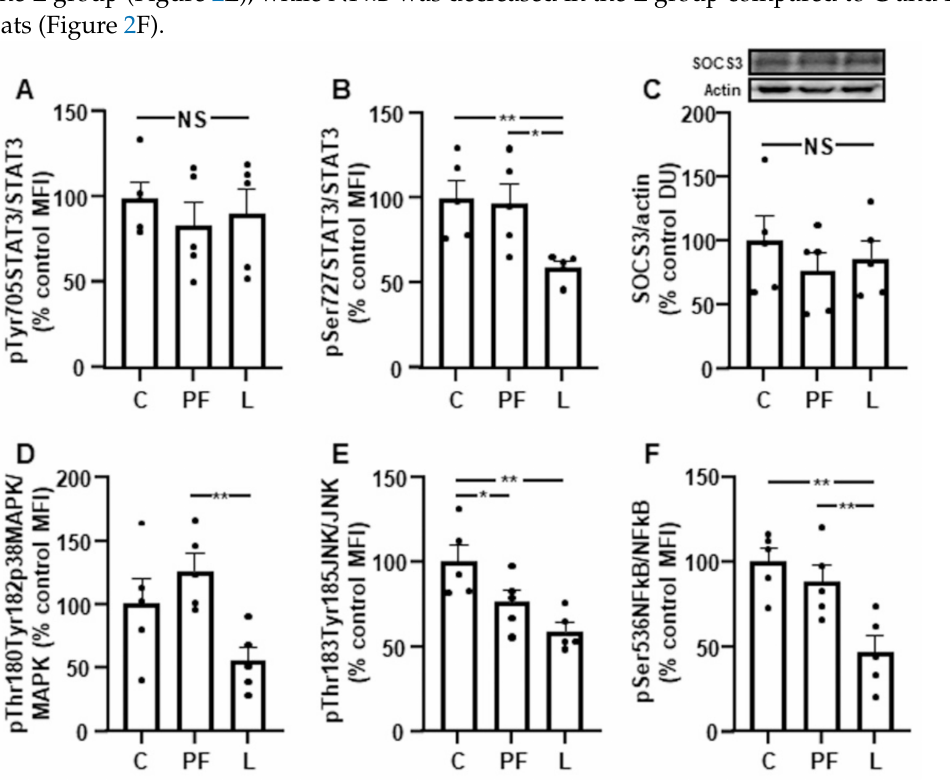
Figure 2. Effect of chronic central leptin infusion on activation of leptin and inflammatory targets. Rel- ative protein levels of ( A ) signal transducer and activator of transcription 3 (STAT3) phosphorylated (p) on Tyr705 (pTyr705STAT3), ( B ) phosphorylated STAT3 on Ser727 (pSer727STAT3), ( C ) suppressor of cytokine signaling (SOCS)3, ( D ) phosphorylated p38 mitogen-activated protein kinase (p38MAPK) on Thr180 and Tyr182 (pThr180Tyr182p38MAPK), ( E ) c-Jun N-terminal kinase (JNK) phosphorylated on Thr183 and Tyr185 (pThr183Tyr185JNK) and ( F ) nuclear factor kappa B (NFkB) phosphorylated on Ser536 (pSer536NFkB) in the gastrocnemius of control rats (C), pair-fed rats (PF) and rats receiving chronic intracerebroventricular leptin infusion (L). Data are presented as means ± SEM. DU, densito- metry units; MFI, median fluorescent intensity; NS, non-significant. * p < 0.05, ** p < 0.01; one-way ANOVA followed by Bonferroni’s test. Dots represent the individual